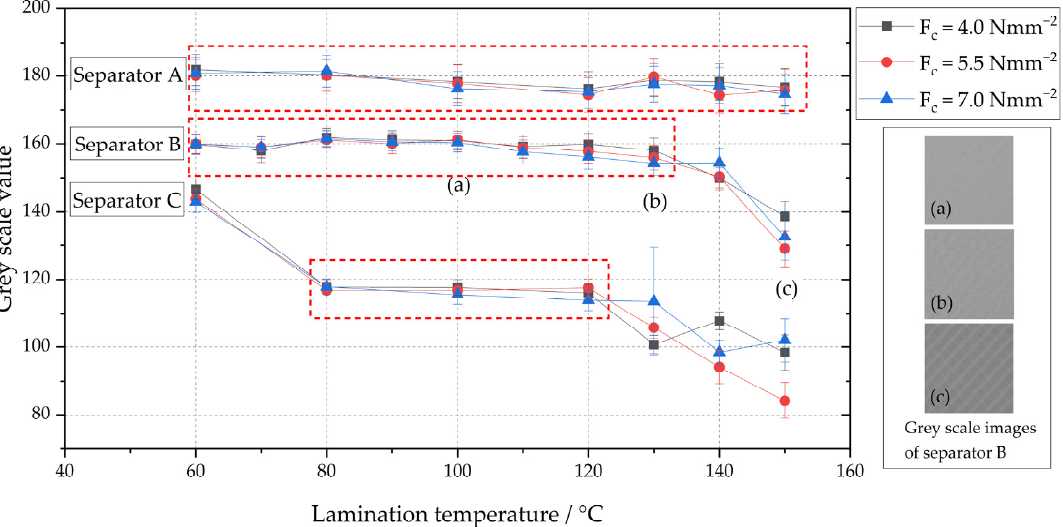
Figure 3. Grey scale values of the surface of separator A (nonwoven separator impregnated with ceramic particles), separator B (membrane-based monolayer) and C (membrane-based trilayer) assigned to different lamination temperature and pressure combinations (F c ); selected images of the surface of separator B at a lamination pressure of 5.5 Nmm − 2 and lamination temperatures of 100 °C ( a ), 130 °C ( b ) and 150 °C ( c ); ideal lamination temperature and pressure ranges are highlighted for each separator by red boxes.